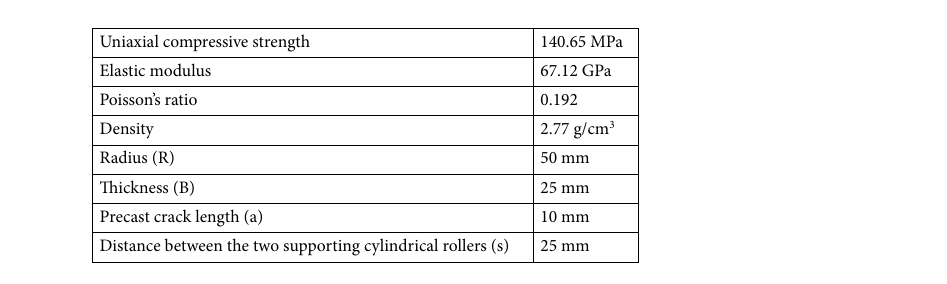
Table 1. Mechanical and geometrical parameters of tuff